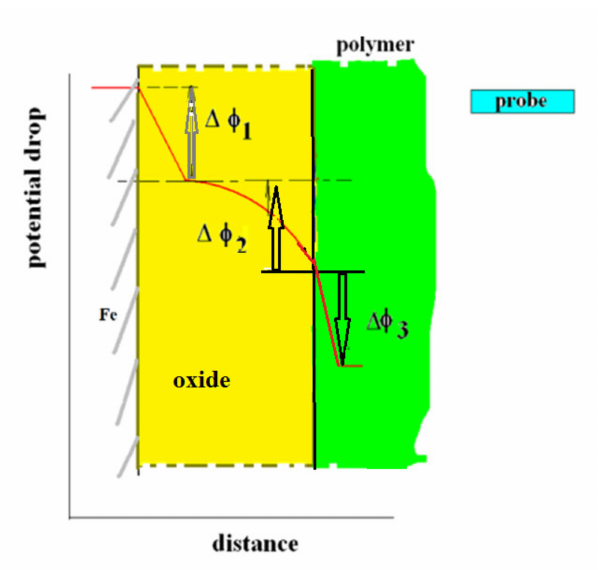
Figure 2. Schematic of potential distribution in the metal-polymer joint. The iron is covered by a semiconducting oxide/hydroxide film. The difference in elec- tron energies of iron and the surface oxide creates a contact potential difference (Schottky junction ∆ ϕ 1 , Equation (2)) [31]. The oxide film adsorbs the species of air or functional groups of the coating that creates two potential drops. The first one is located in the oxide ∆ ϕ ∆ ϕ 2 ) and the second ( 3 ) in a double electric layer in the polymer. Thus, SKP provides the map of the potential drop across the metal surface, which is influenced by the nature of oxide and the polymer species. It is possible to suppose that the Helmholtz equation (Equation (3)) drawing for a parallel-plate capacitor, describes the formation of the layer